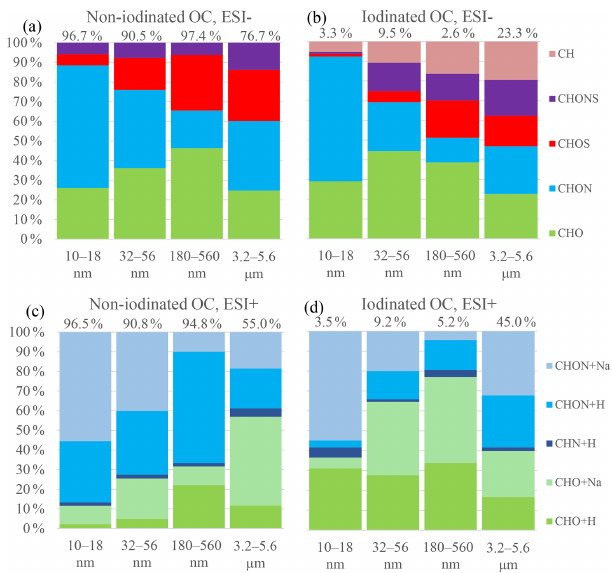
Figure 1. Relative intensity distributions of elemental groups ob- served in 10–18nm, 32–56nm, 180–560nm and 3.2–5.6µm size bins in ESI + and ESI − modes. The percentage above a column de- note the percent of non-iodinated OC (or iodinated OC) intensity in total OC intensity in a size bin. + Na and + H denote [ M + Na] + and [ M + H] + adduct in ESI + mode,